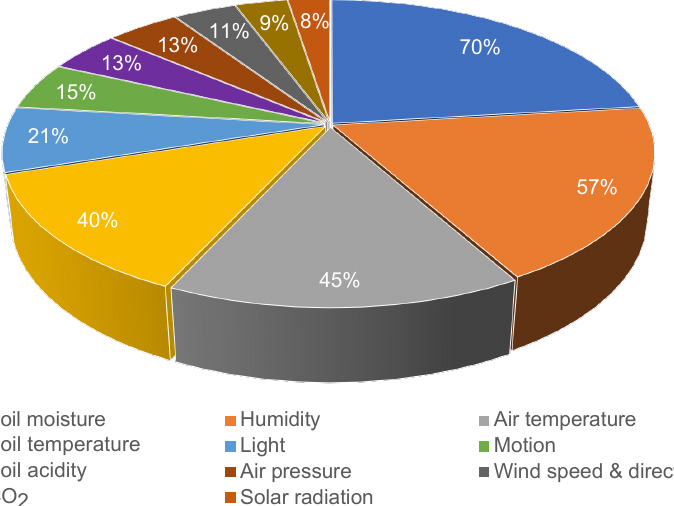
Figure 5. Sensor type distribution of reviewed papers ( N = 53) showing important types in small- holder agriculture. Papers typically report multiple sensor types in